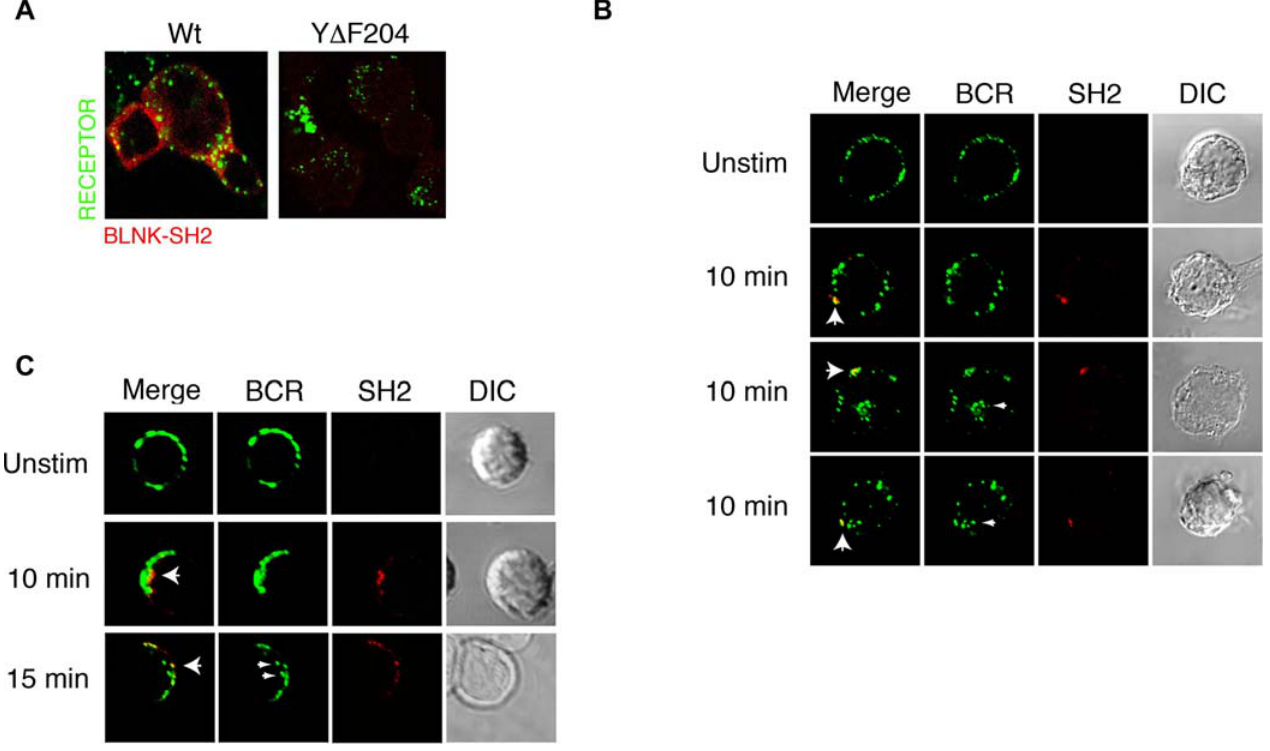
Figure 3. Direct Visualization of BCR Complexes Containing Ig a Phospho-Y 204 (A) A20IIA1.6 cells expressing PDGFR chimeric receptors containing the cytosolic tail of either Ig a or Ig a Y D F204 were stimulated through the chimera with FITC-conjugated antibodies for 10 min, fixed, permeabilized, and counterstained with PE-BLNK-SH2 (SH2). Cells were then visualized using confocal microscopy. (B) BLNK kd cells were stimulated with Cy5-conjugated anti-IgG antibodies for 10 min. Samples were then fixed, permeabilized, counterstained with PE- BLNK-SH2, and visualized by confocal microscopy. Typical results are shown ( n ¼ 150 cells from three independent experiments). (C) Purified BLNK (cid:1) / (cid:1) splenic B cells were stimulated with FITC-conjugated anti-IgM F(ab) 2 fragments for 10 or 15 min and then fixed, permeabilized, counterstained with PE-BLNK-SH2, and visualized by confocal microscopy. Small arrowheads indicate internalized non-phosphorylated BCR complexes while large arrowheads indicate locations of phosphorylated surface BCRs. DOI: 10.1371/journal.pbio.0040200.g003